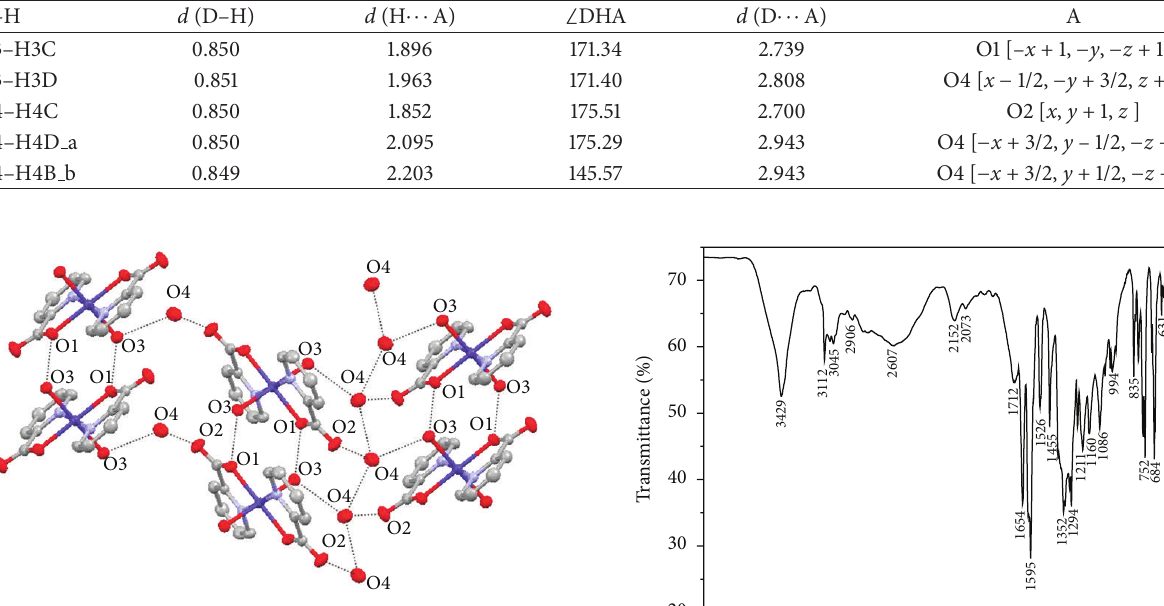
Table 3: Hydrogen bond lengths (˚A) and bond angles ( ∘ ) for the title complex.